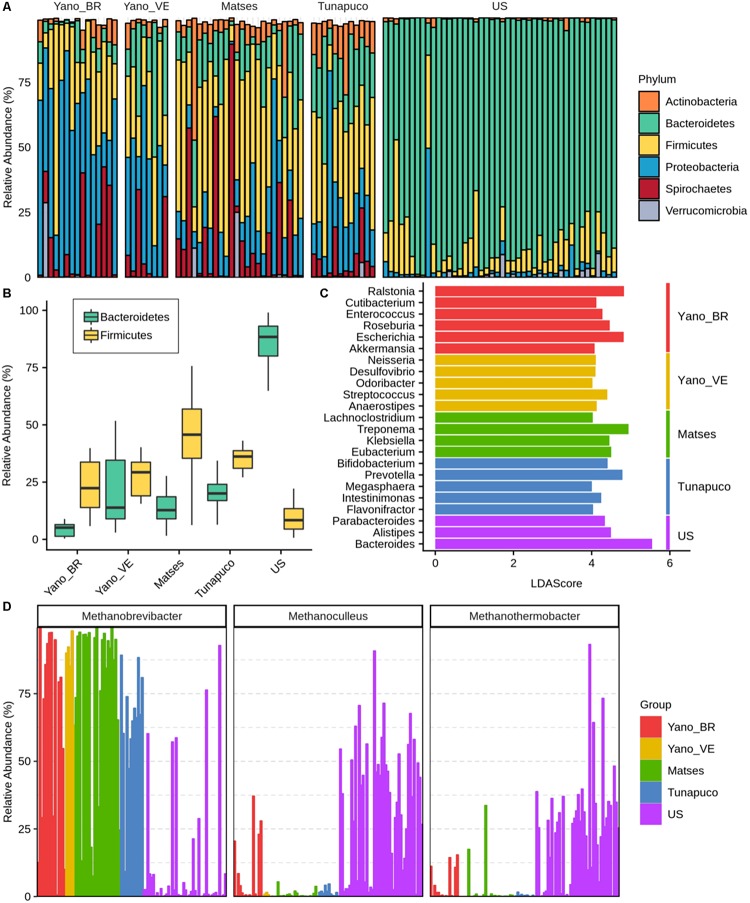
Bacterial and archaeal taxa differences among traditional and urban groups. (A) Barplot representing the relative abundance (percentage) of the most frequent phyla in the gut microbiomes. (B) Boxplots showing the Bacteroidetes and Firmicutes abundance (percentage) in each group. (C) Bar chart showing the LDA scores >4 of bacterial genera found to be significantly associated with each group. (D) Relative abundance of the most prevalent archaeas identified in the groups. Yano_BR, Yanomami/Brazil; Yano_VE, Yanomami/Venezuela; US, US individuals.